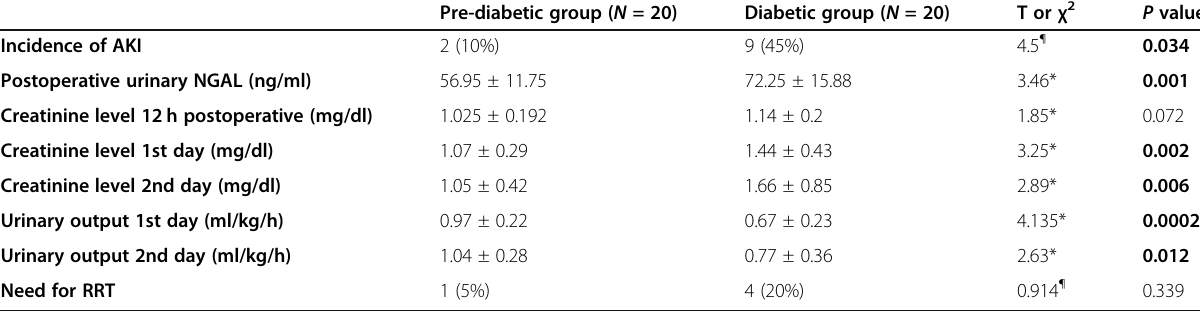
Table 4 Comparison between the two studied groups regarding the incidence and determinants of AKI Pre-diabetic group ( N =